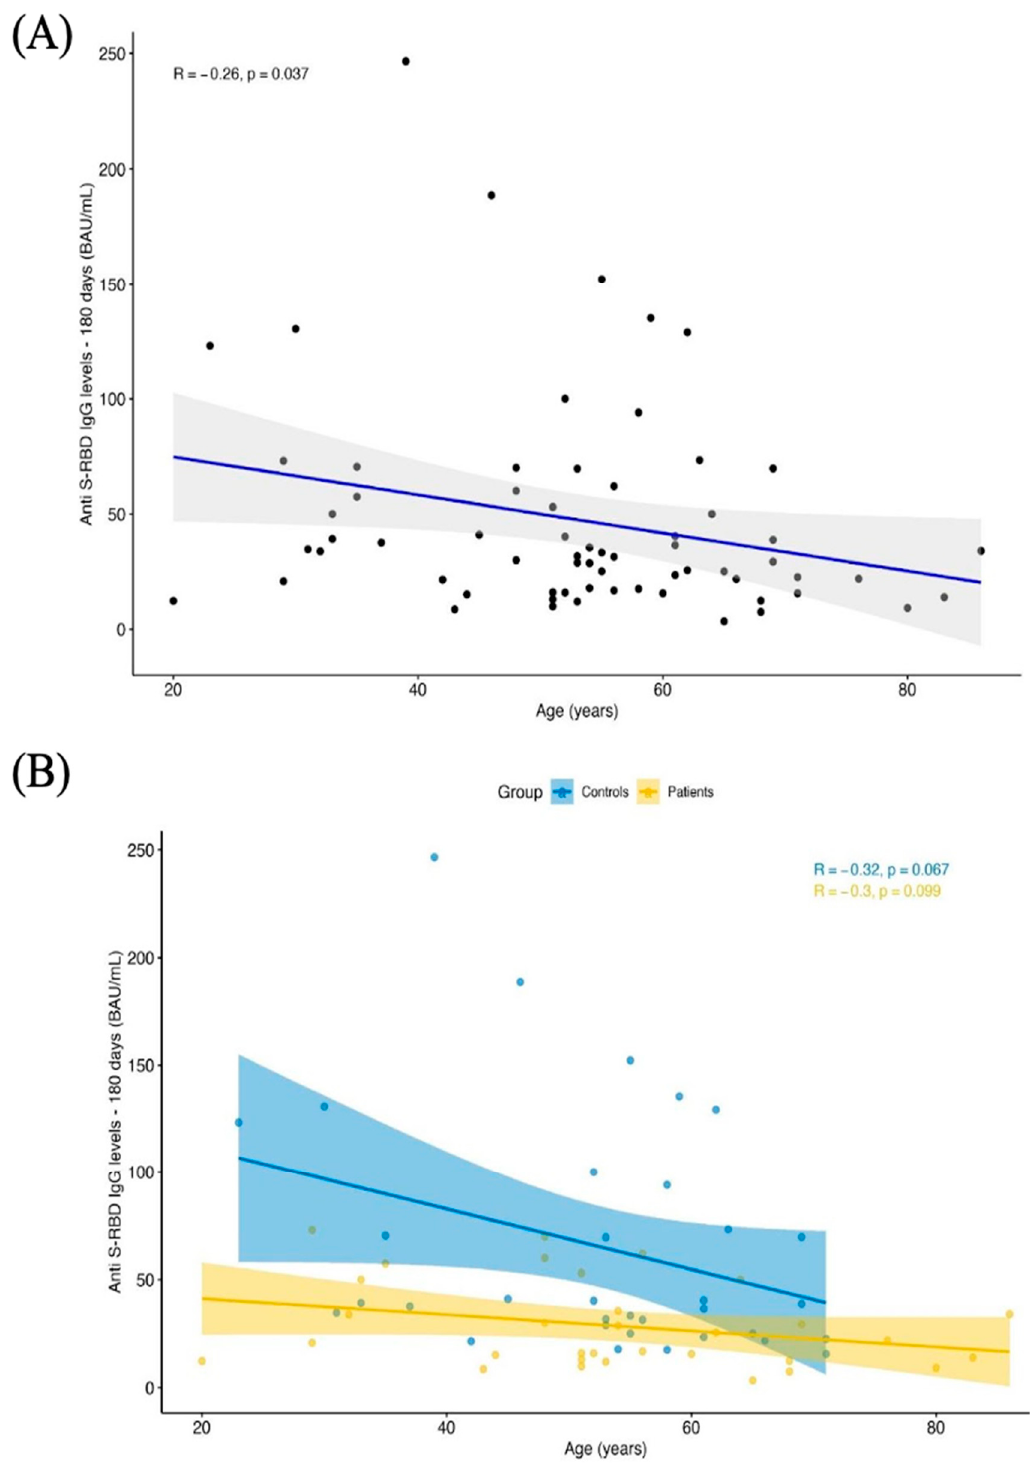
Figure 2. Regression analysis showing the relationship between age factor and antibody responses in the whole group of enrolled subjects ( A ) and within every single group ( B ).